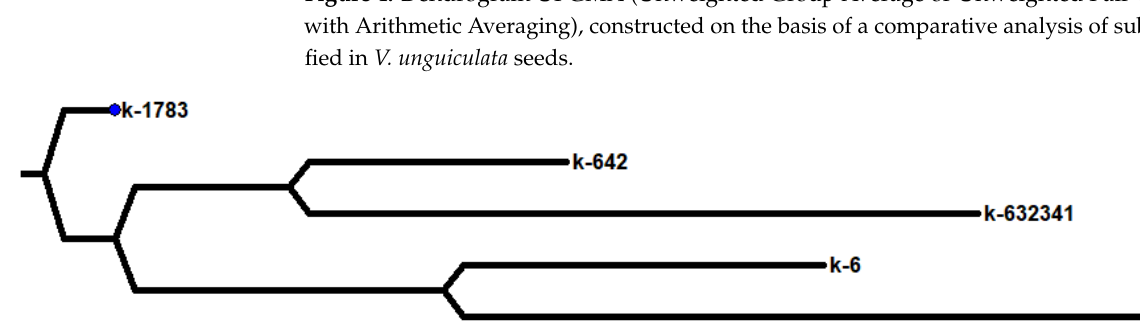
Figure 5. Consensus tree built using the criterion of maximum parsimony based on the results of a comparative analysis of substances identified in V. unguiculata seeds (Ci = 77, consistency index—the proportion of homoplasia in the total number of changes in traits, L = 63, Ri = 33 retention index—the number of synapomorphies determined by the data).